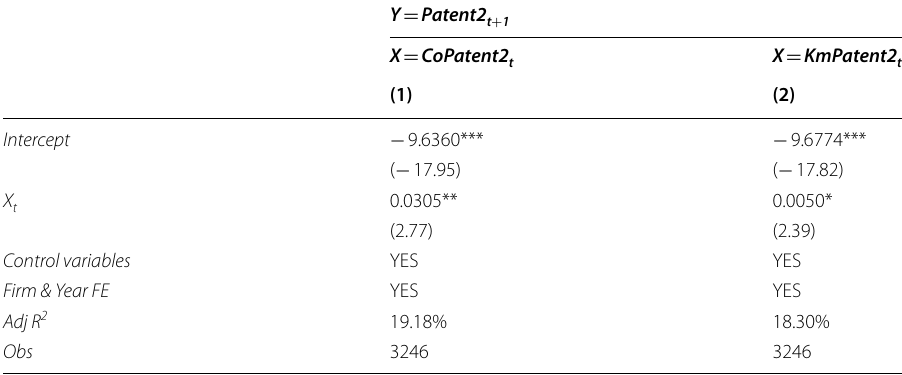
This table presents the regression results of the overall sample in regression (5). We have replaced RD1 for Patent2 . Column (1) and (2) respectively shows the regression results of two explanatory variables on the dependent variable. Firm fixed effects and year fixed effects are controlled in the regression. The T statistic is in parentheses under the coefficient. *, **, and *** mean statistical significance at 5%, 1%, and 0.1% respectively